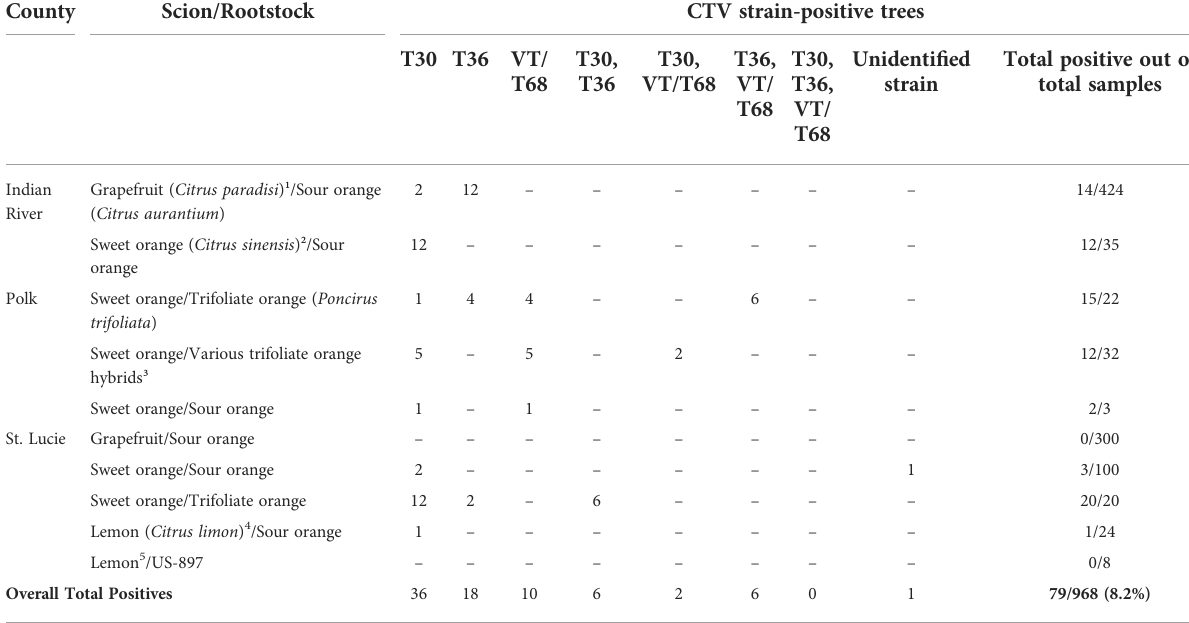
TABLE 3 Summary of citrus tristeza virus (CTV) prevalence in Florida citrus trees during the 5-year (2018-2022) general survey. County